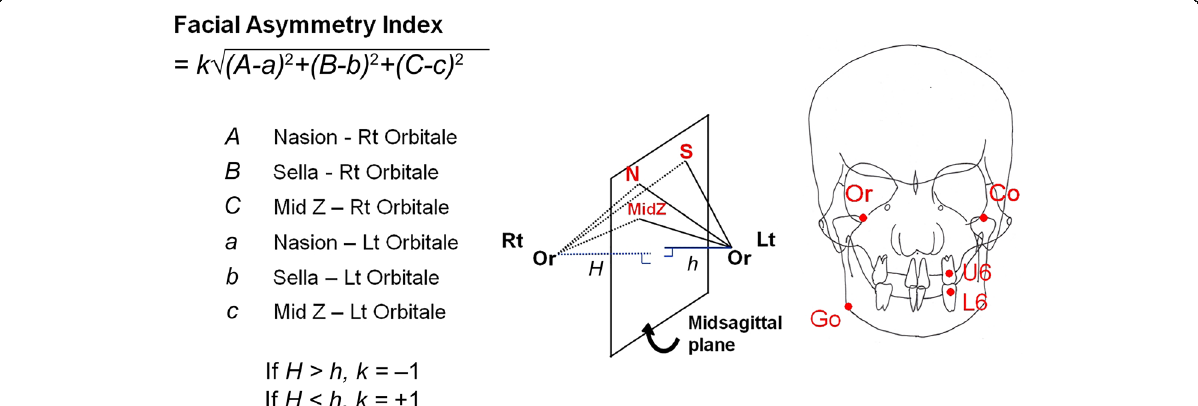
Fig. 2 Calculation of facial asymmetry index on orbitale (Or). The formula was designed to show the degree of facial asymmetry by using the difference between the distances from the reference point to bilateral measurement landmarks. If both orbitales were on 3 dimensionally symmetric positions to the 3 reference landmarks (nasion, sella, MidZ), the value of facial asymmetry index was 0. As the asymmetry of both orbitales increased, the facial asymmetry index on orbitale increased. The formula was designed so that the right deviation had a negative value while the left deviation had a positive value. The facial asymmetry indices were calculated on the 5 bilateral landmarks — orbitale (Or), condylion